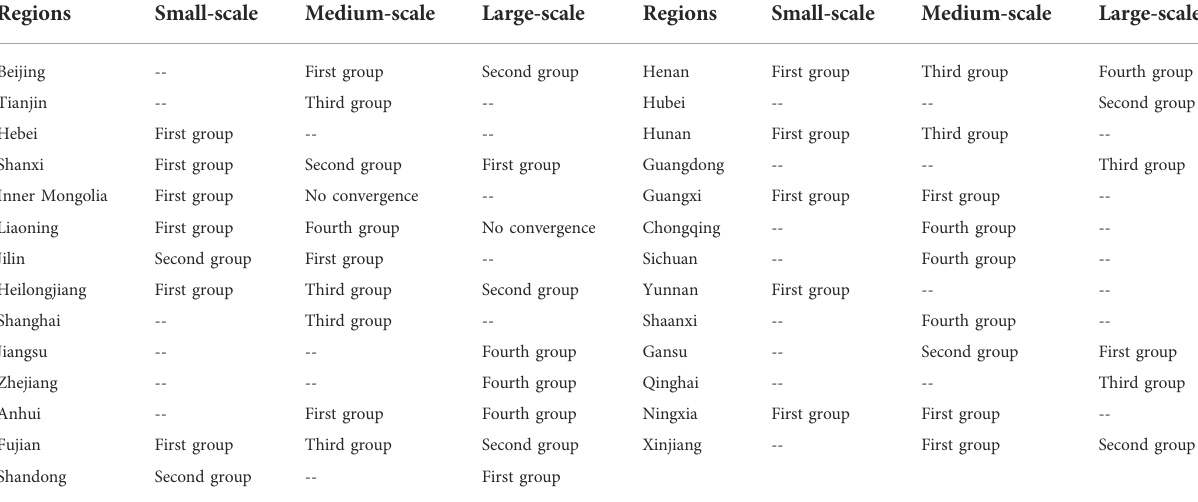
TABLE 5 Environmental ef fi ciency of dairy farming on different scales.